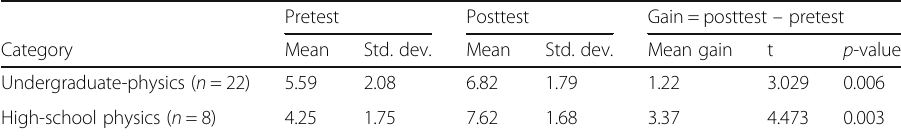
Table 4 Descriptive and inferential statistics of students exposed to only high-school physics courses and students with undergraduate physics